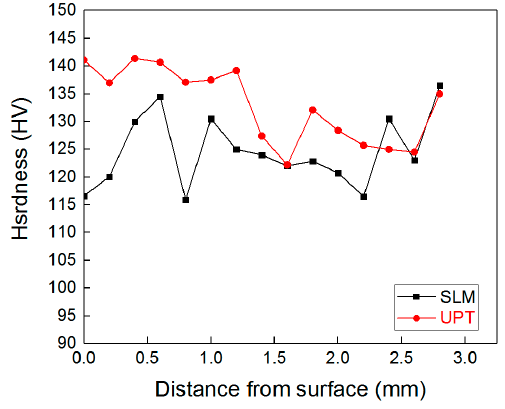
Figure 4. Hardness of specimens before and after UPT.